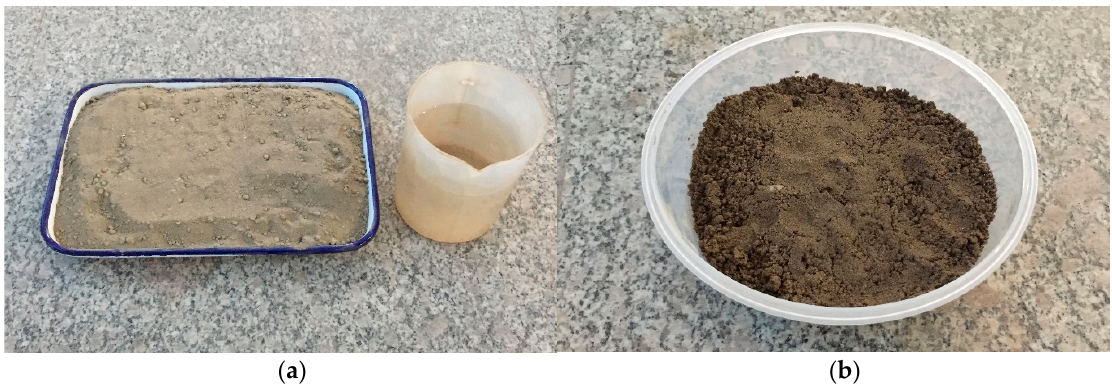
Figure 2. Preparation of the sandy soil. ( a ) Dry sand, ( b ) Sand soil (15% water content).